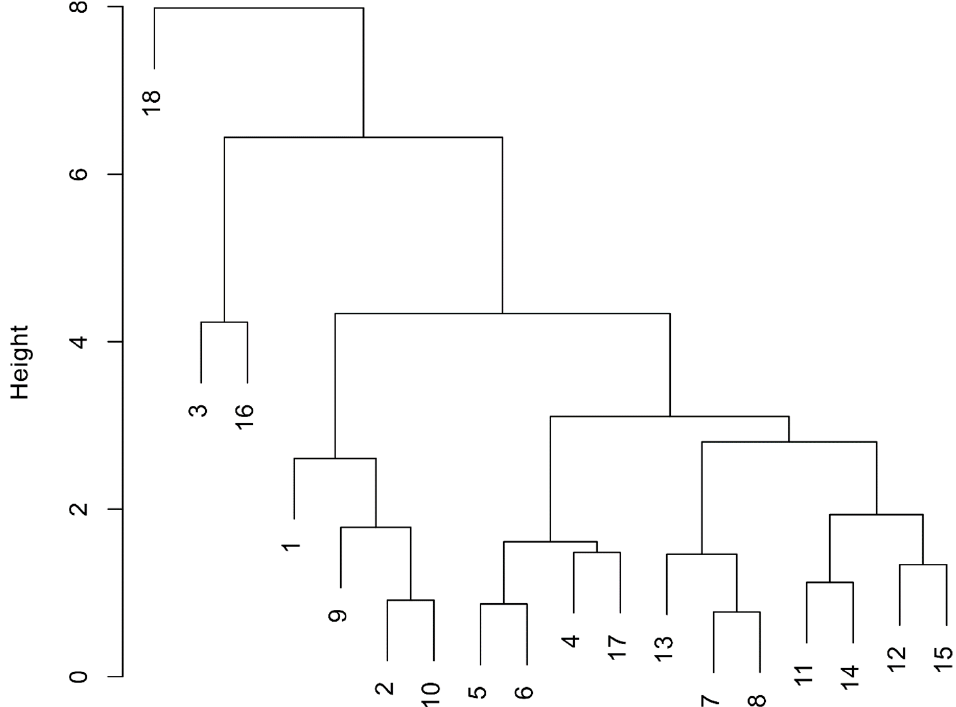
Figure 2. The dendrogram illustrating structures composed of the points with coordinates defined by the scaled sample tree parameters (DBH, H, H*, FMN, FMN 1000 , LN). PCA indicated that the first three principal components (PC1-3) explained 92.6% of the total variance. Figure 3 shows the points representing data in PC1 and PC2 coordinates. The length of the arrow projection on the axes illustrates the contribution of the variable to PC1 and PC2. Similar directions of the arrows representing FMN and DBH variables indicate co-variability of the parameters. Similarly, FMN 1000 and LN shared the trend